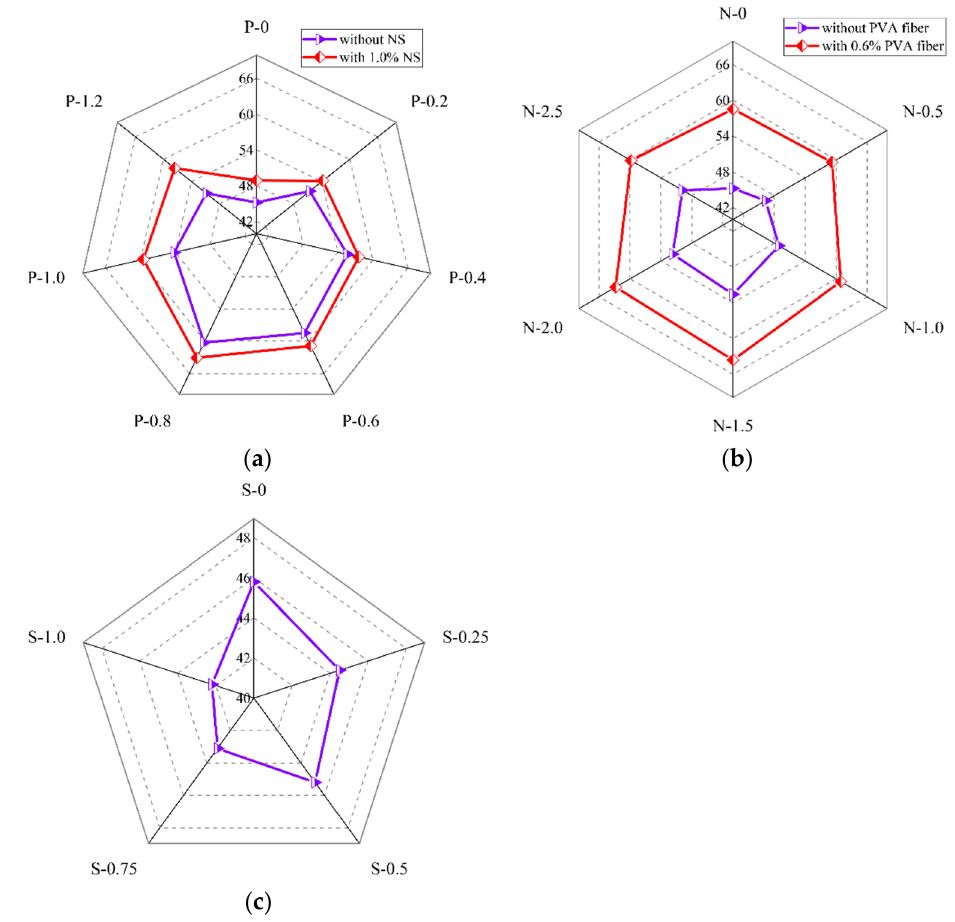
Figure 9. Influence of ( a ) PVA fiber, ( b ) NS, and ( c ) SP on compressive strength of geopolymer com ‐ posites.